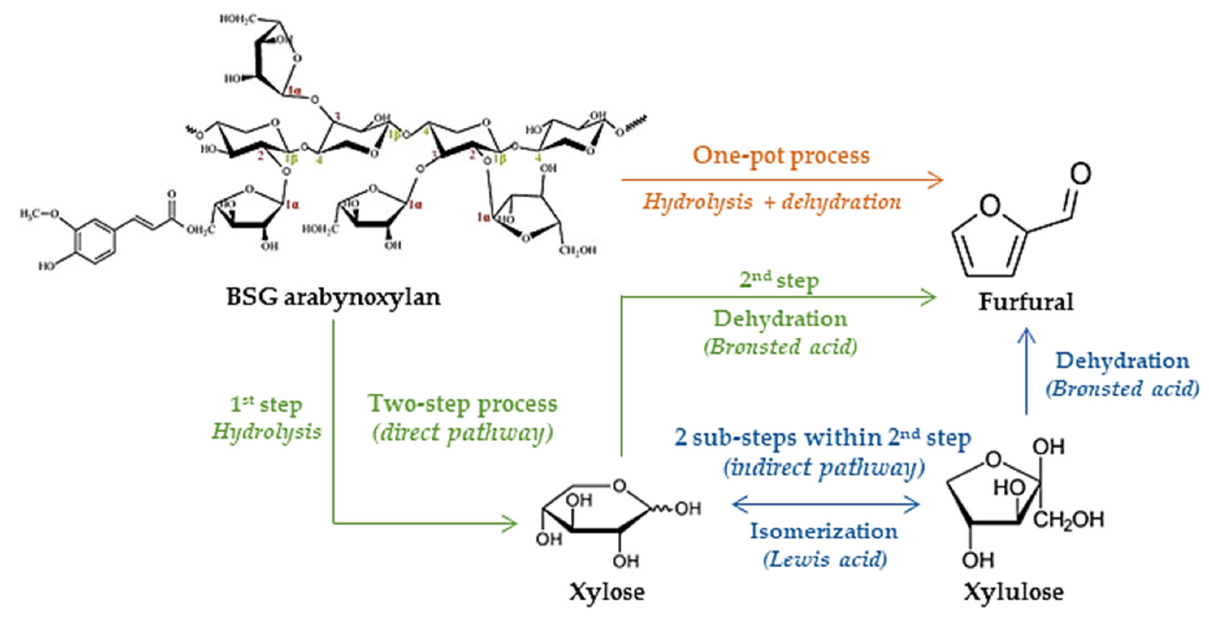
Figure 6. “One ‐ pot” and “two ‐ step” furfural production pathways. Figure 6. “One-pot” and “two-step” furfural production